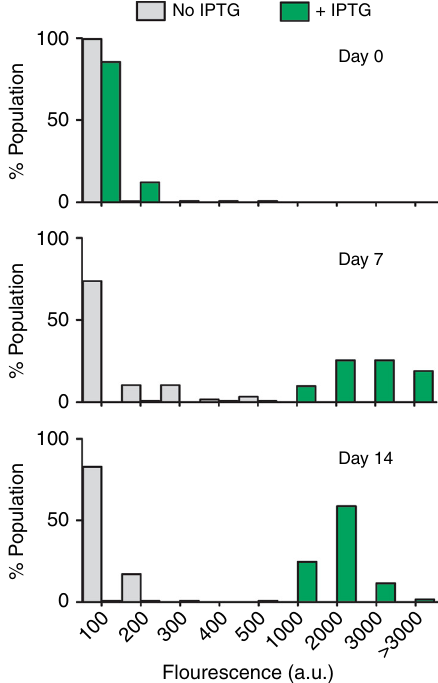
Fig. 4 gfp expression capacity during deep starvation. B. subtilis strain Δ spoIIE containing an inducible green fl uorescent protein (GFP) reporter (strain DG017, amyE::Phyperspank-sfGFP ) was incubated in starvation buffer for 0, 7, and 14 days, followed by incubation in the presence or absence of 1 mM isopropyl β - D -1-thiogalactopyranoside (IPTG) for 4 h, after which cells were imaged by fl uorescence light microscopy. The fl uorescence of approximately 100 cells was quanti fi ed for each condition. Cells were binned based on their fl uorescence intensities (arbitrary units), and the number of cells in each bin were plotted as histograms. Two